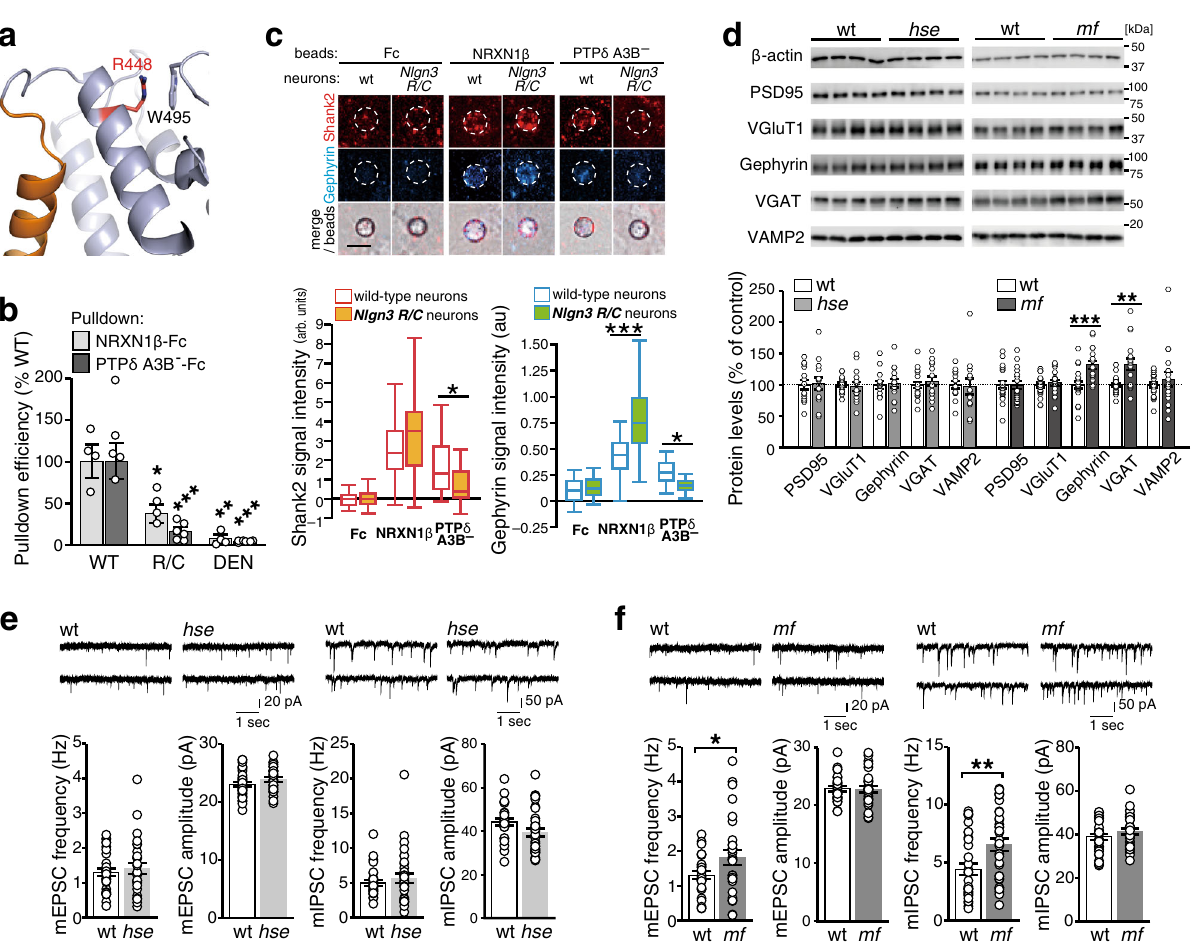
Fig. 6 Phenotypic resemblance between Nlgn3 R/C ASD model and Nlgn3 mf mice. a Close-up view of the area around Arg448 of NLGN3. Arg448 and Trp495 are shown as sticks. The coloring scheme is the same as that in Fig. 3a, except that Arg448 is colored in red. b Pulldown ef fi ciencies of wild-type NLGN3 (WT), NLGN3-R448C (R/C), and NLGN3-DEN/AAA (DEN) by NRXN1 β and PTP δ A3B – ( n = 4 and 6 experiments for NRXN1 β and PTP δ A3B – , respectively). c NRXN1 β - and PTP δ A3B – -induced excitatory and inhibitory postsynaptic differentiation in Nlgn3 R/C cortical neurons were visualized by Shank2 (red) and gephyrin (blue) immunostaining (top) and quanti fi ed ( n = 27 and 30 Fc-beads, 29 and 31 NRXN1 β -beads, and 36 and 33 PTP δ A3B – - beads for wild-type and Nlgn3 R/C neurons, respectively) (bottom). Scale bar, 5 μ m. d Representative immunoblots (top) and quanti fi cation of expression levels (bottom) of synaptic proteins in Nlgn3 hse and Nlgn3 mf mutant mice and their wild-type littermates ( N = 14 each for Nlgn3 hse and wild-type littermates; N = 20 and 18 for Nlgn3 mf and wild-type littermates, respectively). e and f Representative mEPSC and mIPSC traces and summary graphs from layer 2/3 pyramidal neurons of somatosensory cortex in acute slices of Nlgn3 hse ( e ) and Nlgn3 mf ( f ) mutant mice ( n = 28, 31, 29, and 27 cells from 4 Nlgn3 hse , 6 wild- type, 5 Nlgn3 mf, and 5 wild-type mice, respectively for mEPSC; n = 33, 27, 32 and 31 cells from 6 Nlgn3 hse , 4 wild-type, 6 Nlgn3 mf, and 7 wild-type mice, respectively for mIPSC). Data in ( c ) are presented as box plots. Horizontal line in each box shows the median, box shows the IQR and the whiskers are 1.5 × IQR. Data in ( b , d , e , and f ) represent mean ± s.e.m. * p < 0.05, ** p < 0.01 and *** p < 0.001, Tukey ’ s test in ( b and c ), and two-sided Student ’ s t -test in ( d and f ). See Supplementary Table 4 for additional statistics and exact p